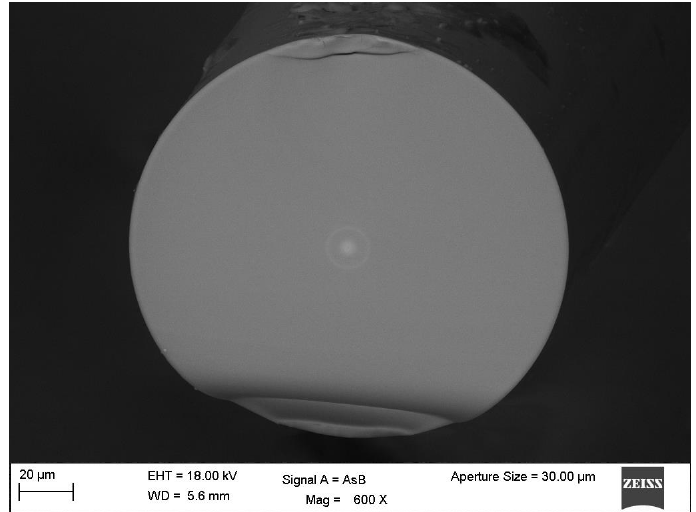
Figure 1. Image of Non-zero dispersion-shifted fiber cross section.